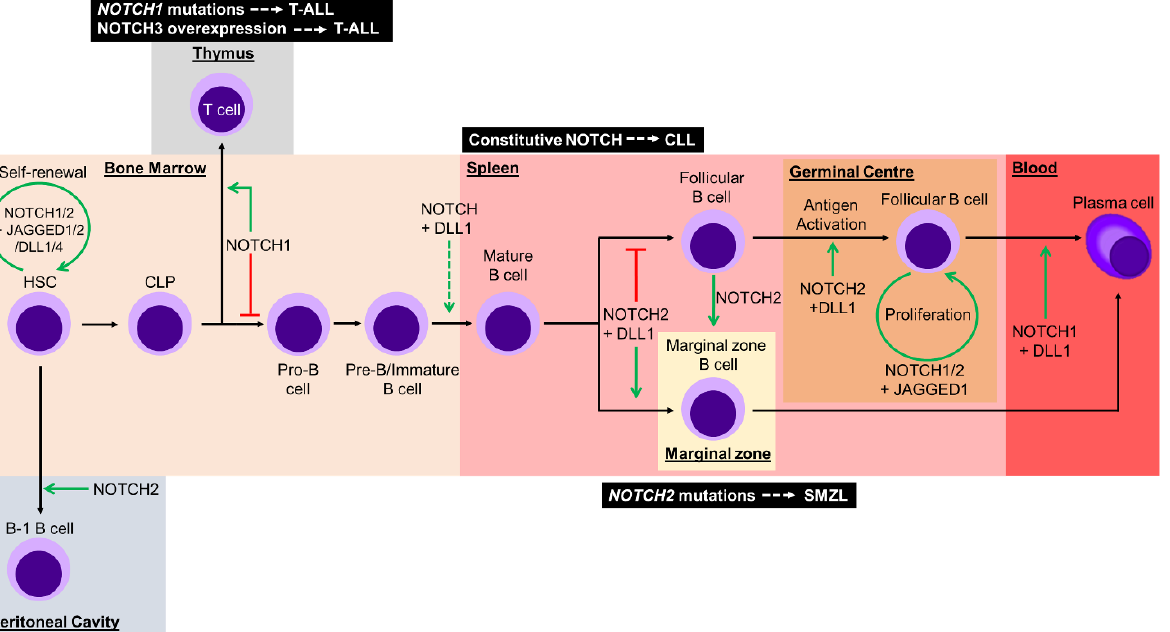
Figure 3. Development of hematopoietic stem cells (HSCs) from common lymphoid progenitors (CLPs) through to terminally differentiated plasma cells requires mediation of Notch signals at multiple stages. Within the bone marrow, HSCs are maintained in their pluripotent state through Notch signaling with surrounding stromal cells. NOTCH2 signaling promotes peritoneal B1 B cell differentiation. CLPs encounter a Notch signaling checkpoint that determines T or B cell fate through activation or inhibition of NOTCH1 signaling, respectively. Notch signaling with DELTA-LIKE1 (DLL1) is proposed to function as another checkpoint alongside negative selection against self-antigen of pre-B/immature B cells, prior to migration from the bone marrow into secondary lymphoid organs. Within the spleen, mature B cells develop into marginal zone B cells with NOTCH2 and DLL1 mediating Notch activation, whilst the absence of Notch signaling regulates follicular B cells. Notch signal is capable of mediating plasticity and inducing transdifferentiation from follicular B cells to functional marginal zone B cells. Upon antigen encounter in the germinal center, NOTCH2- and DLL1-mediated Notch signaling induces follicular B cell activation. Proliferation of activated follicular B cells is mediated by Notch activation through JAGGED1. Lastly, NOTCH1 and DLL1 mediated Notch signaling promotes terminal differentiation to plasma cells. Green arrows represent Notch signaling, whilst the red lines represent the absence of Notch signaling. The green dashed arrow represents a yet to be elucidated requirement for Notch signaling. Dysregulation of Notch signaling can contribute to lymphoid malignancies (black boxes) at different stages of development. T-ALL: T-acute lymphoblastic leukemia; CLL: chronic lymphocytic leukemia; SMZL: splenic marginal-zone lymphoma.